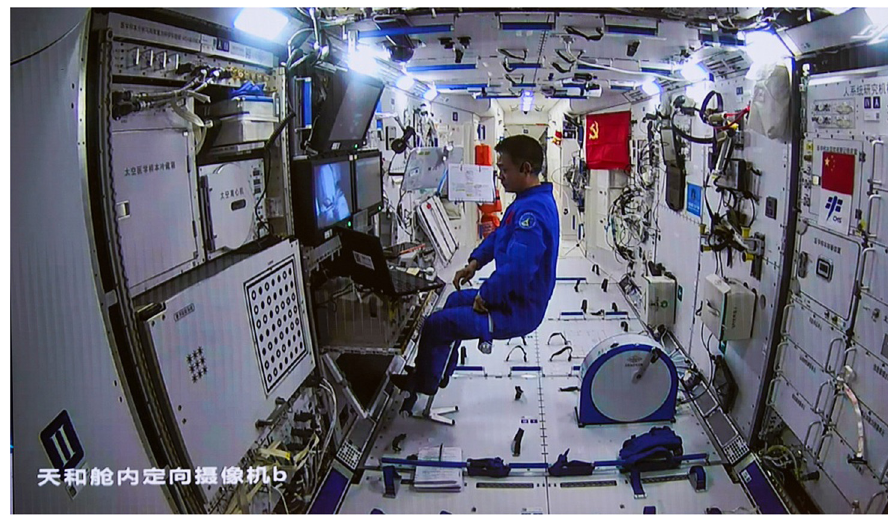
Figure 2: The astronaut returned to the Tianhe core module after leaving the module in the Shenzhou 12